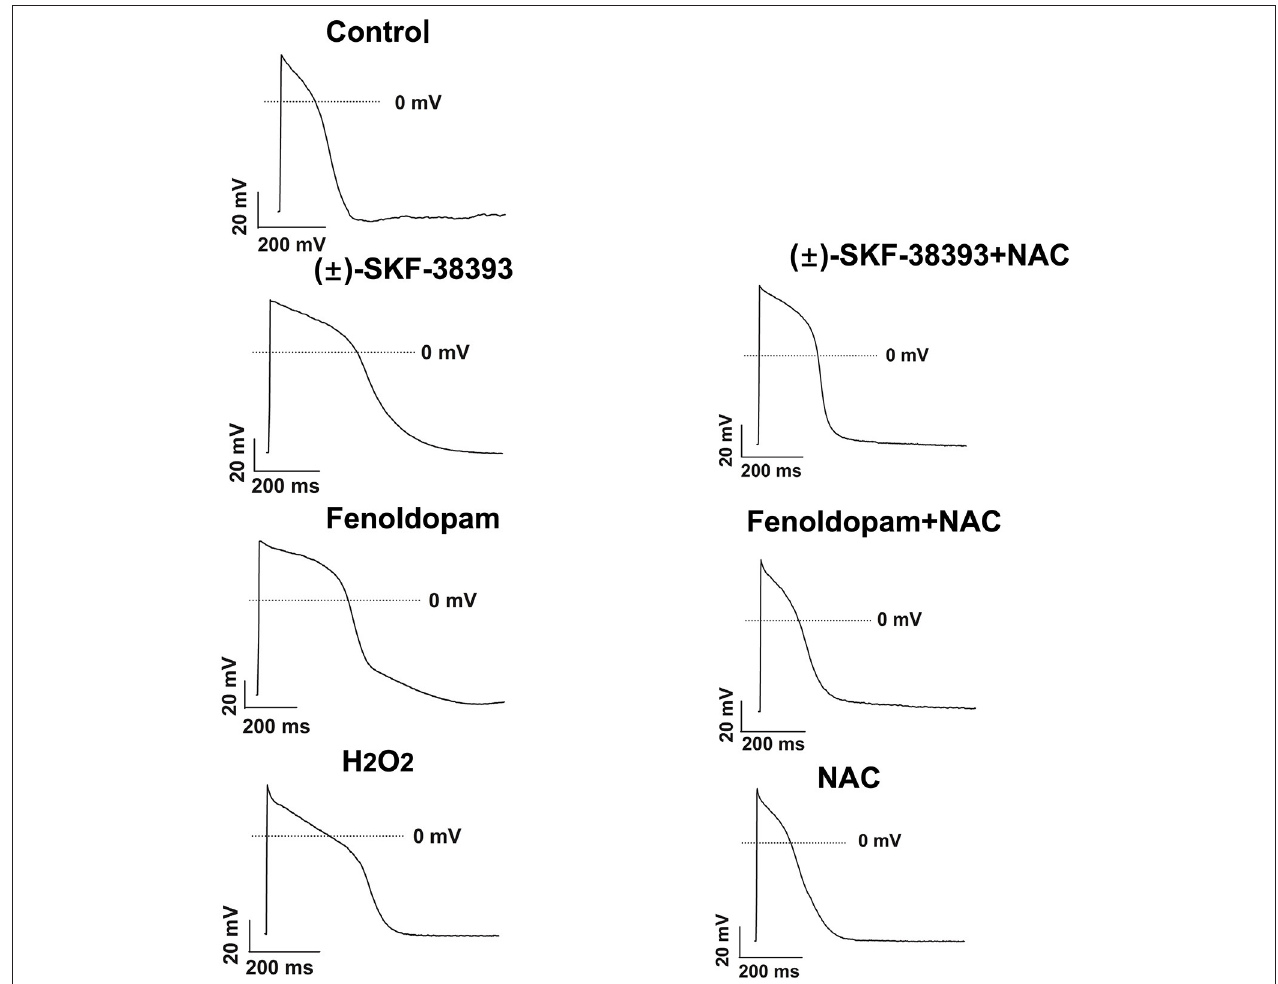
FIGURE 4 | ROS mediated the effects of ( ± )-SKF 38393 or fenoldopam on action potentials. hiPSC-CMs were challenged by vehicle (Control) or 50 µ M ( ± )-SKF 38393 and 5 µ M fenoldopam or 100 µ M H 2 O 2 (H 2 O 2 ) in the presence or absence of a ROS-blocker (1mM NAC), or NAC alone for 1h. APs were recorded at 1Hz. Shown are examples of APs in each group cells. Statistical data were summarized in Table 2 .